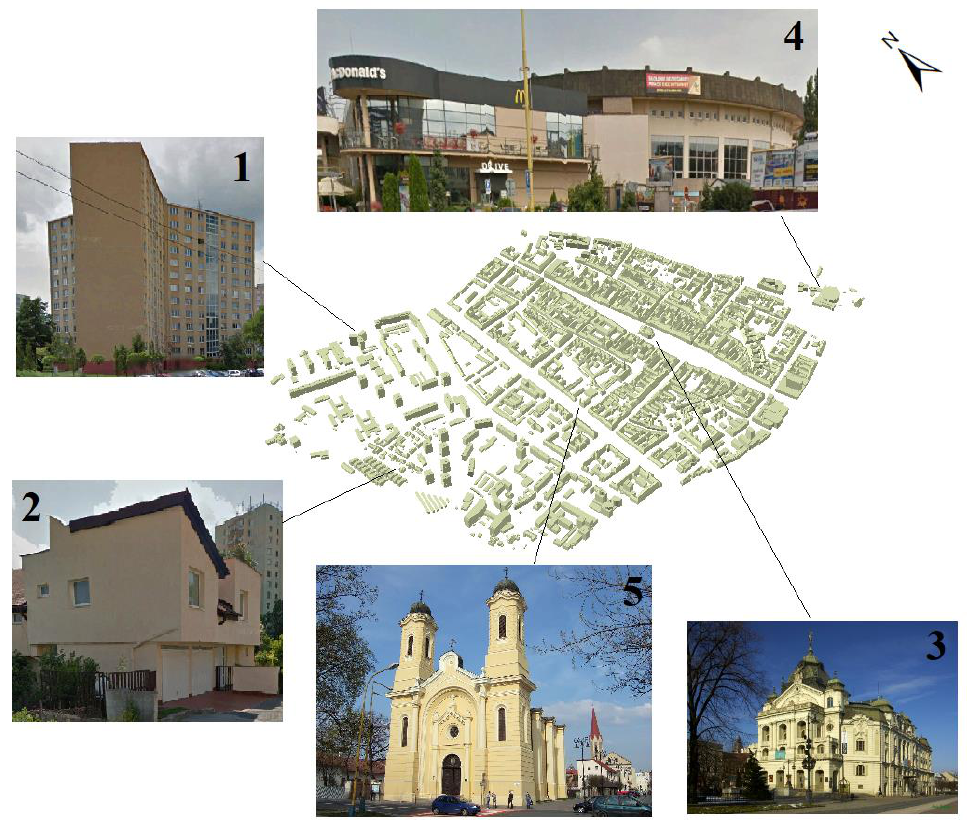
Figure 2. Positions of the selected locations in the city of Košice: Apartment house, Českoslov- enská Street ( 1 ); Residential house, Muránska Street ( 2 ); State Theatre, Hlavná Street ( 3 ); Municipal Street ( 1 ); Residential house, Mur á nska Street ( 2 ); State Theatre, Hlavn á Street ( 3 ); Municipal swim- swimming pool, Protifašistických bojovníkov Street ( 4 ); and Greek-Catholic Church of the Nativity ming pool, Protifašistick ý ch bojovn í kov Street ( 4 ); and Greek-Catholic Church of the Nativity of the of the Virgin Mary, Moyzesova Street ( 5 ). Virgin Mary, Moyzesova Street ( 5